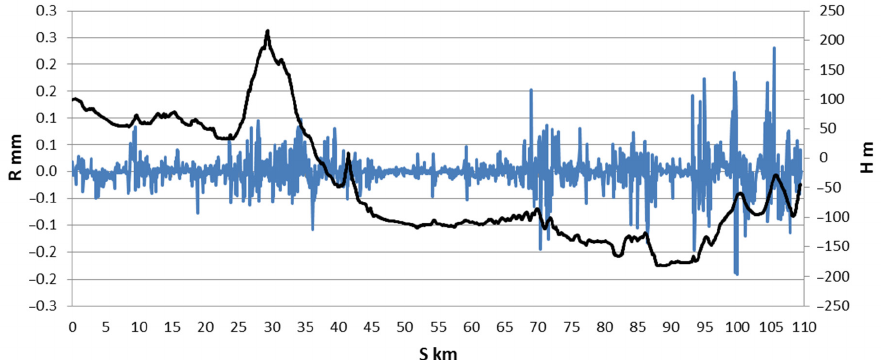
Figure 2. Refraction correction calculated for every set-up in fore leveling in blue and cross section of the leveling line in black